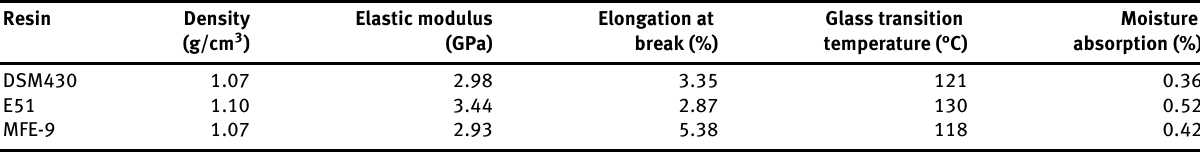
Table 1: Properties of matrix resins used in this study. Resin